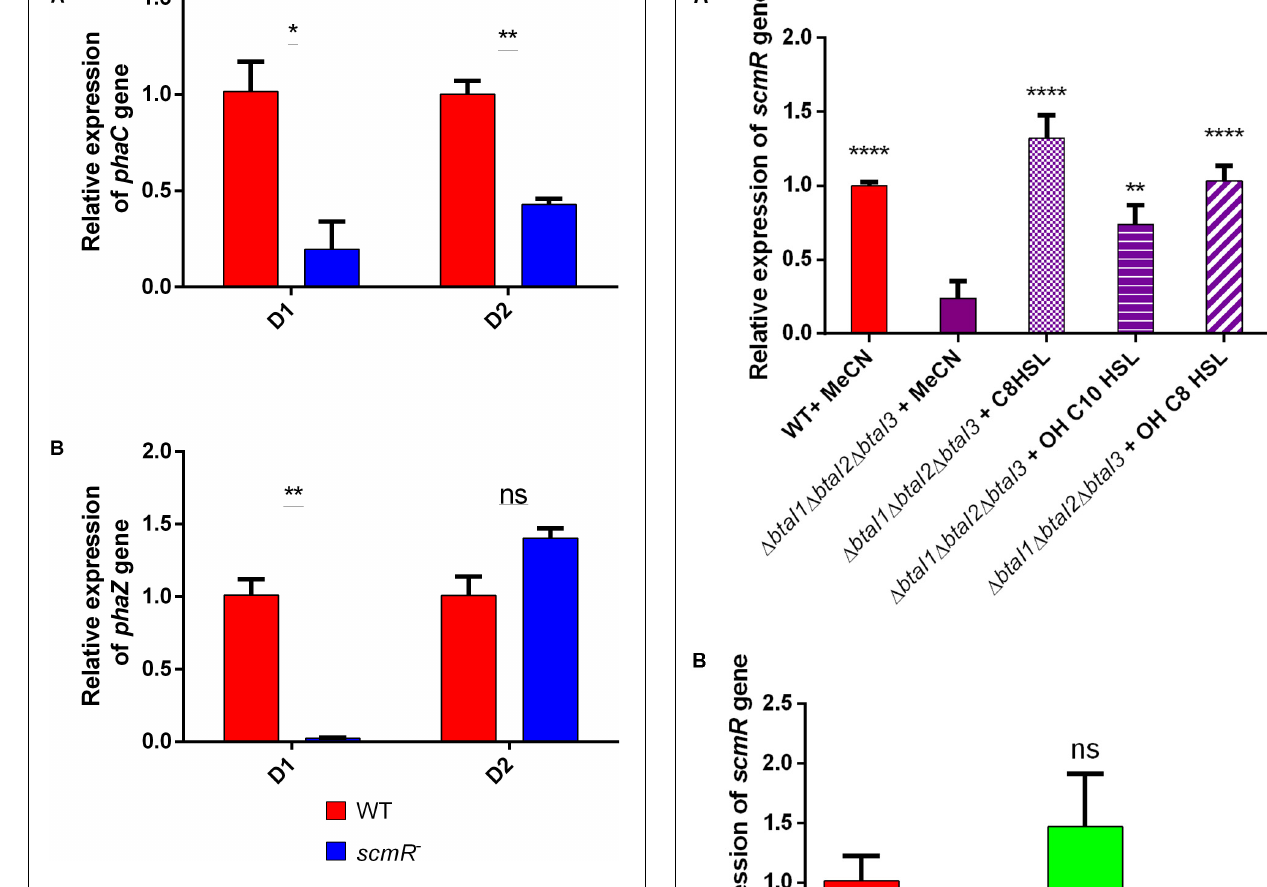
FIGURE 5 | ScmR plays a role in PHA biosynthesis at the transcriptional level. Levels of transcription for the phaC (A) and phaZ (B) genes were determined by RT-qPCR in the wild type and the scmR − mutant strains. D1 and D2 are days of cultivation. The error bars represent standard deviation from the mean ( n = 3 independent cultures). Data analyzed using a one-way ANOVA with post hoc. Dunnett’s multiple comparisons tests ( ∗∗ p < 0.01, ∗ p < 0.05, and ns = not significant).